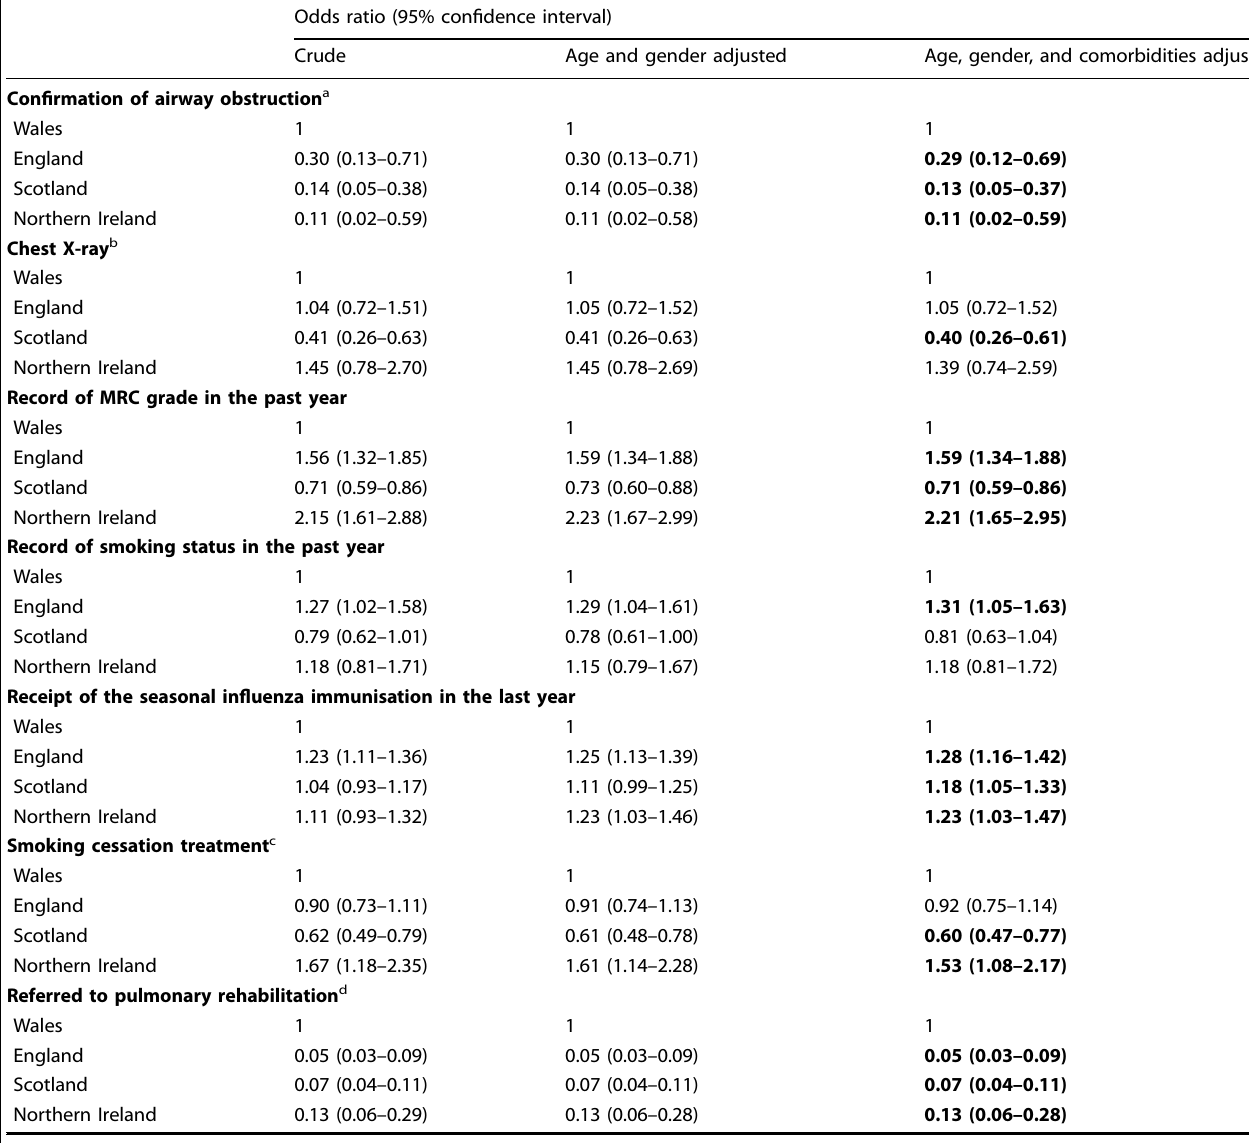
Table 1. Odds ratios and 95% con fi dence intervals for receipt of item of COPD care for each UK country relative to Wales in crude and adjusted